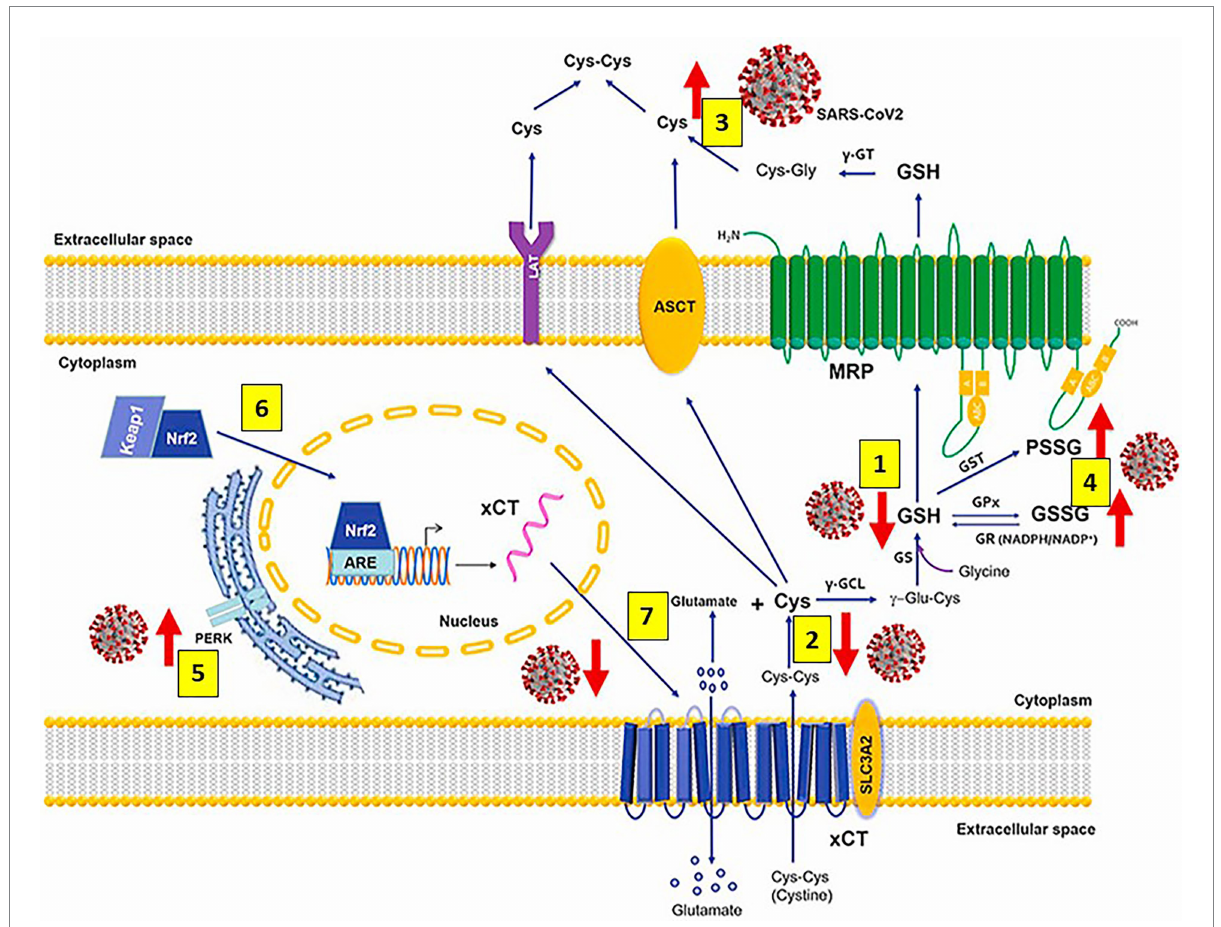
FIGURE 4 Severe acute respiratory syndrome coronavirus 2 (SARS-CoV-2) infection alters metabolism and redox function of cellular glutathione (GSH). SARS-CoV-2 markedly decreases GSH levels [1], that could be explained by lower intake of the GSH precursor cysteine (Cys) [2] and increased efflux of cellular thiols [3]. Increased levels of oxidized glutathione (GSSG) and protein glutathionylation [4] along with upregulation of endoplasmic reticulum stress marker protein kinase R (PKR)-like endoplasmic reticulum kinase (PERK) [5] are also observed. Antivirals activate the Kelch-like ECH-associated protein 1 (Keap1)-Nuclear factor erythroid 2-related factor2 (Nrf2)-antioxidant response element (ARE) redox regulator pathway, releasing Nrf2 [6] to regulate the expression of genes that control antioxidant, inflammatory and immune system responses (including the cystine (cys-cys)/glutamate transporter xCT and the membrane transporter multidrug resistance protein [MRP], which are decreased and markedly upregulated, respectively, during infection); restoring GSH levels in the infected cells and facilitating GSH synthesis [7] and activity. Abbreviations: γ -GT: γ -glutamyl transferase; ASCT: alanine-serine-cysteine transporter; LAT: L-type amino acid transporter; PSSG: S-glutathionylated Proteins; GST: glutathione-S-transferase; γ -GCL: γ -glutamate cysteine ligase; γ -glutamyl cysteine; GST: glutathione-S- transferase; GPx: glutathione peroxidase; GR: glutathione reductase; NADPH: reduced NADP+; NADP+: Nicotinamide adenine dinucleotide phosphate; GS: glutathione synthetase; xCT (SLC7A11)/SLC3A2: cystine/glutamate transporter light (xCT [SLC7A11]) and heavy (SLC3A2) chains. Modified from Bartolini et al.